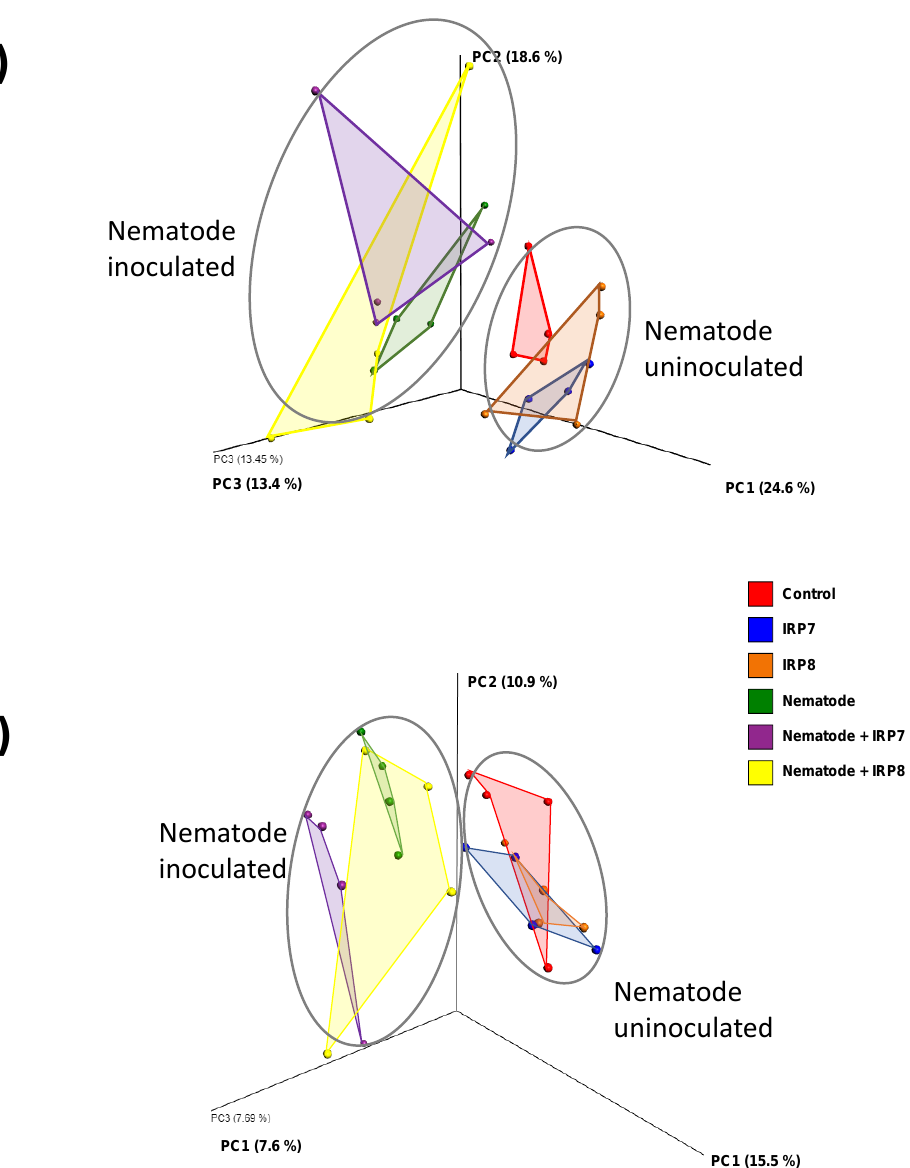
Figure 3. Three-dimensional graphs showing the principal coordinate analysis (PCoA) of the ( A ) weighted and ( B ) unweighted UniFrac distances from the pine rhizosphere microbiota. C, negative control; IRP7, samples treated with Pseudomonas koreensis IRP7; IRP8, samples treated with Lysobacter enzymogenes IRP8; N, nematode-inoculated; Nematode + IRP7, nematode-inoculated samples treated with P. koreensis IRP7; Nematode + IRP8, nematode-inoculated samples treated with L. enzymogenes IRP8. A clear distinction was observed between the nematode-inoculated and uninoculated samples that were separated into distinct